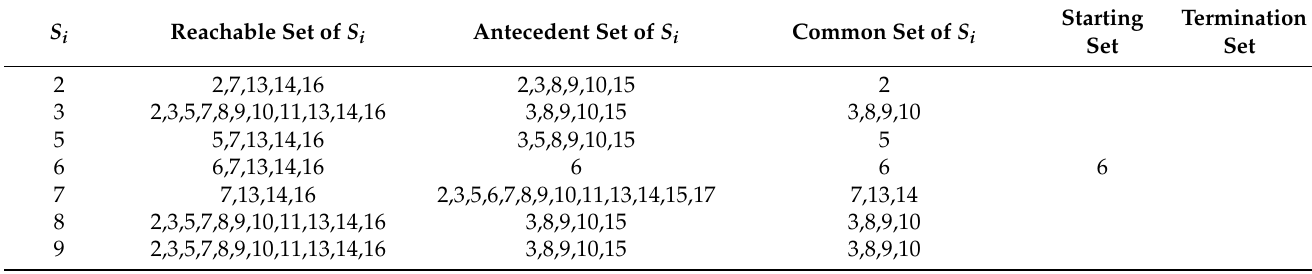
L 5 = { S 6 , S 15 , S 17 } . Table 11 is a summary table of each stratum: Table 11. Reachable set and antecedent set of